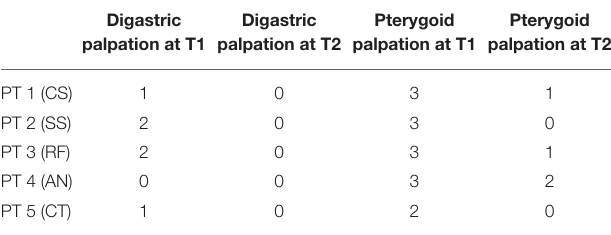
TABLE 2.2 | Digastric and pterygoid palpation test after treatment compared with baseline. Digastric Digastric Pterygoid Pterygoid palpation at T1 palpation at T2 palpation at T1 palpation at T2